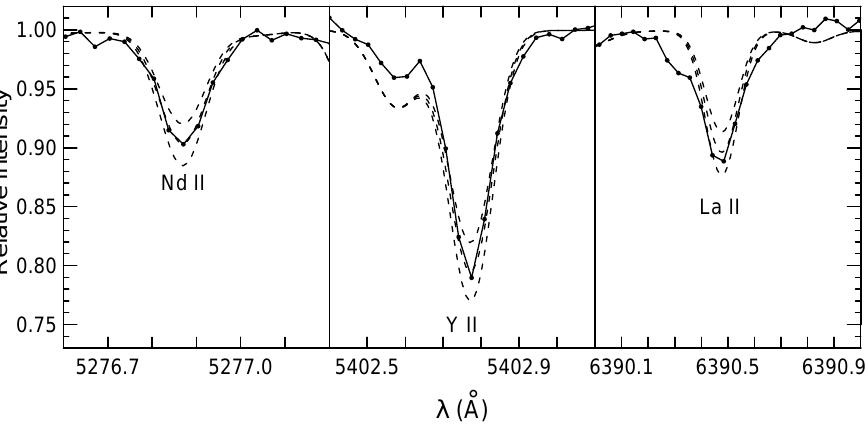
Fig. 6. Synthetic spectrum fit to the Nd ii line at 5276.806 ˚A, Y ii at 5402.78 ˚A and La ii at 6390.48 ˚A. The observed spectrum is shown as a solid line. The dashed lines are synthetic spectra with [Nd = Fe] = 0 : 11, 0.21 and 0.31 dex, [Y = Fe] = (cid:0) 0 : 07, 0.03 and 0.13 dex and [La = Fe] = (cid:0) 0 : 07, 0.03 and 0.13 dex for Nd ii , Y ii and La ii lines,